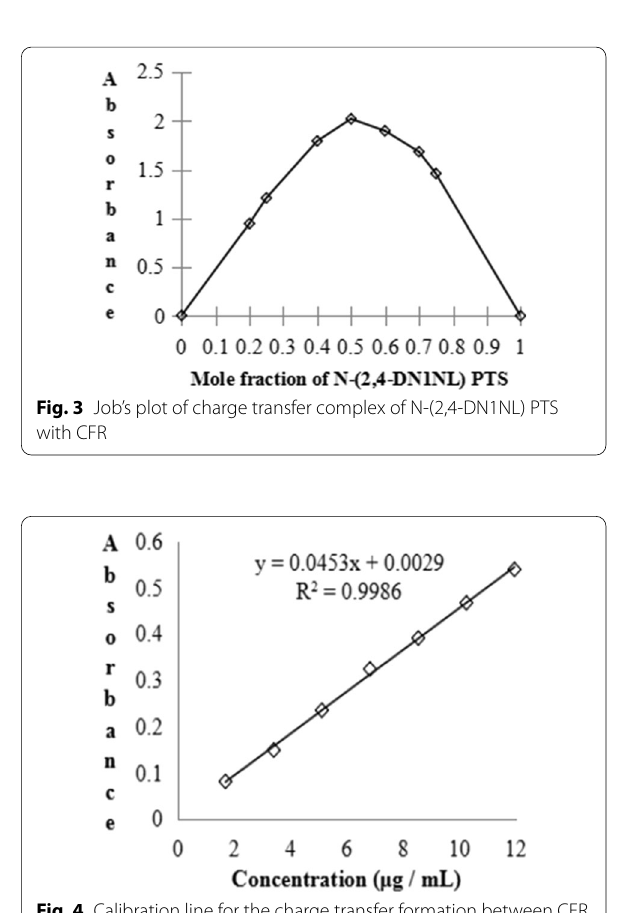
Fig. 4 Calibration line for the charge transfer formation between CFR and N-(2,4-DN1NL) PTS